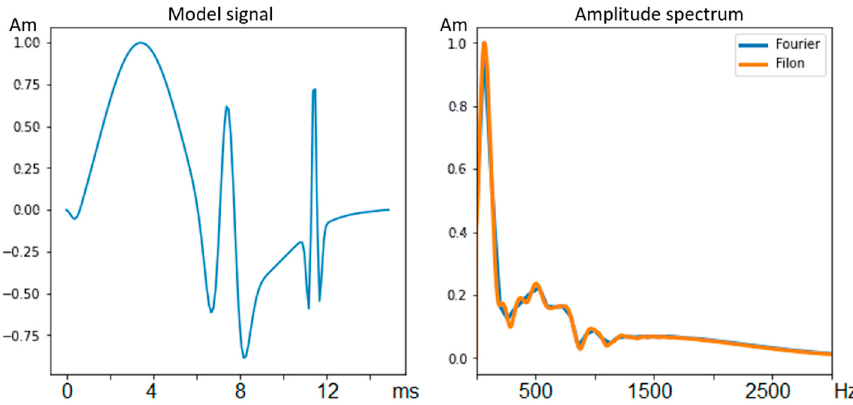
Figure 4. Calculation of the spectrum from the model signal using the standard procedure and based on Filon’s method. The blue color on the right side of the figure displays the Fourier transform result and the orange color on the right side of the figure displays the Filon transform result.